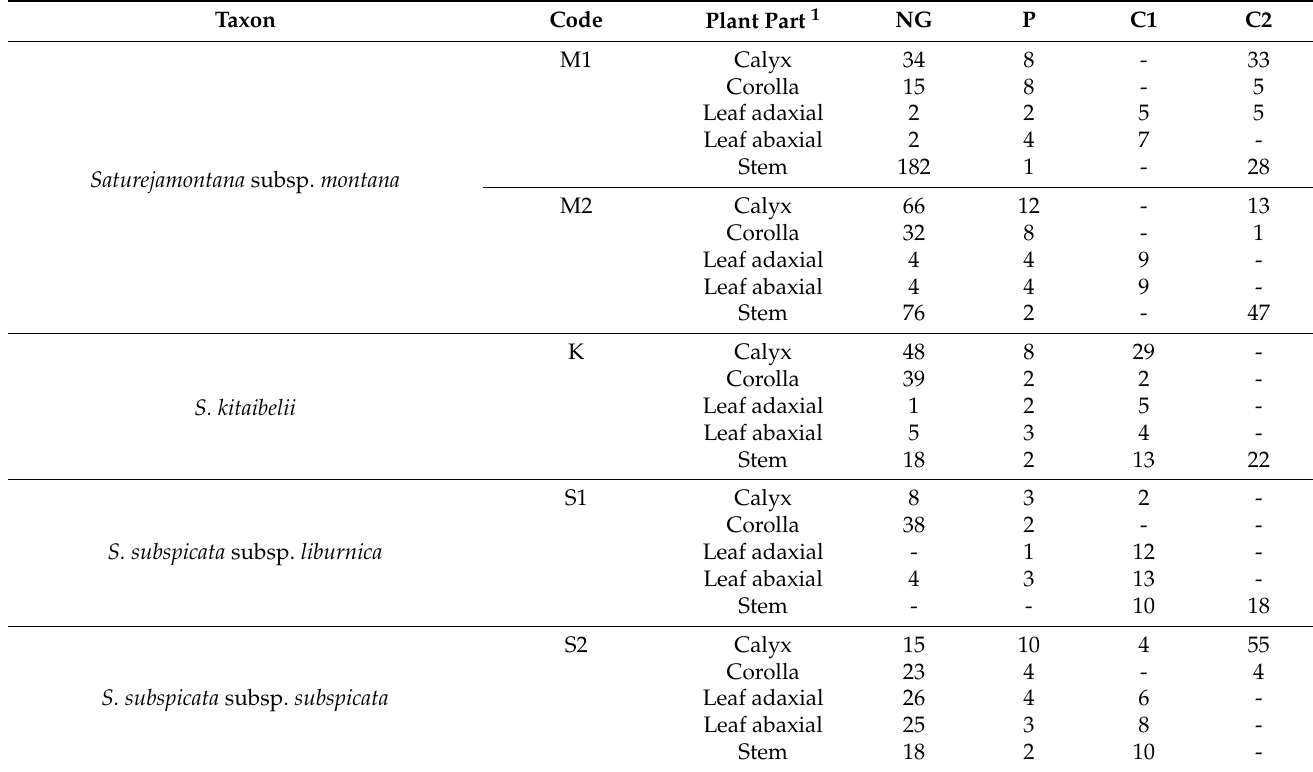
Table 1. Number of non-glandular and glandular trichomes per 0.3 mm 2 of Satureja montana , S. kitaibelii , and S. subspicata based on SEM micrographs. Taxon Code Plant Part